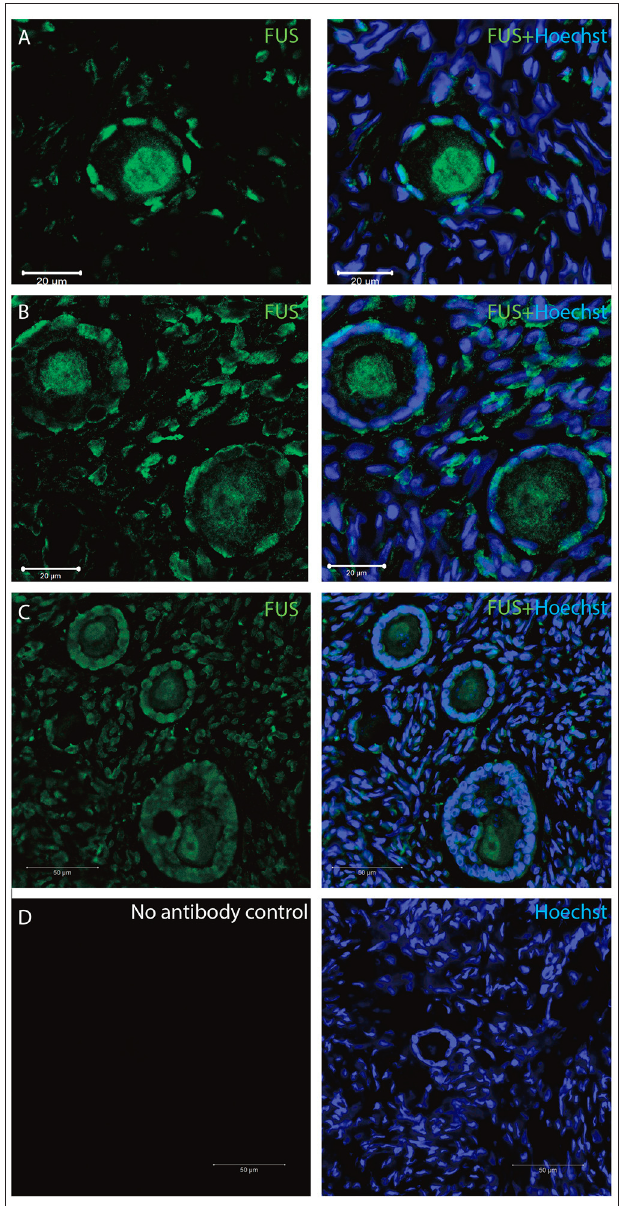
FIGURE 5 | Intra-ovarian distribution of FUS in human primordial, and primary follicles. The FUS protein was detectable in (A) primordial follicles, (B,C) primary follicles (C) late pre-antral/early antral follicles. All samples were compared to a (D) no-antibody control. Hoechst staining identifies the nucleus of cells. Scale bars; 30 µ